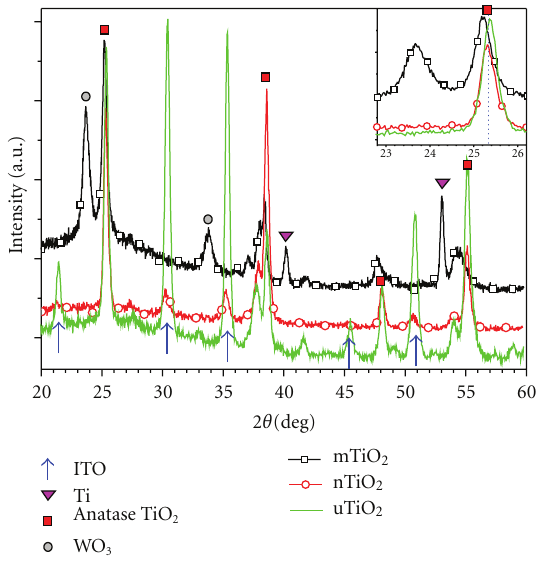
Figure 1: XRD patterns of the mTiO 2 , nTiO 2 , and uTiO 2 films.